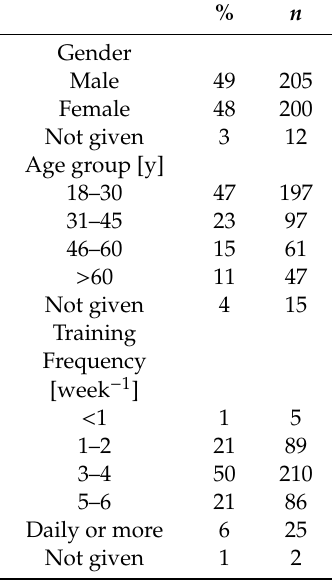
Table 1. Subject characteristics as percent and frequency ( n ) of the study